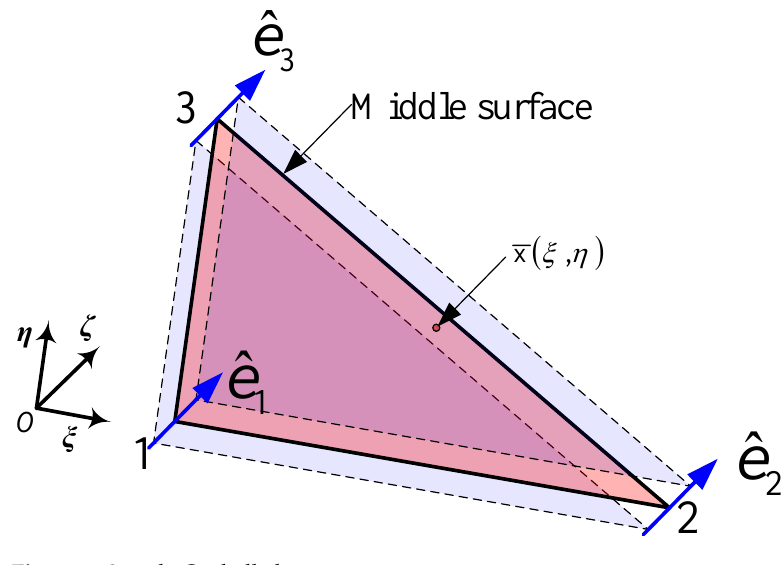
Figure 2. 3-node C0 shell